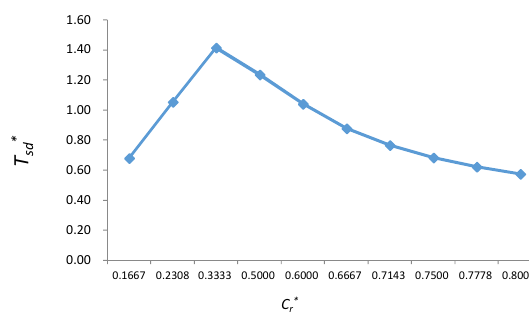
Figure 10. Influence of right lung dimensionless compliance on dimensionless suction duration.